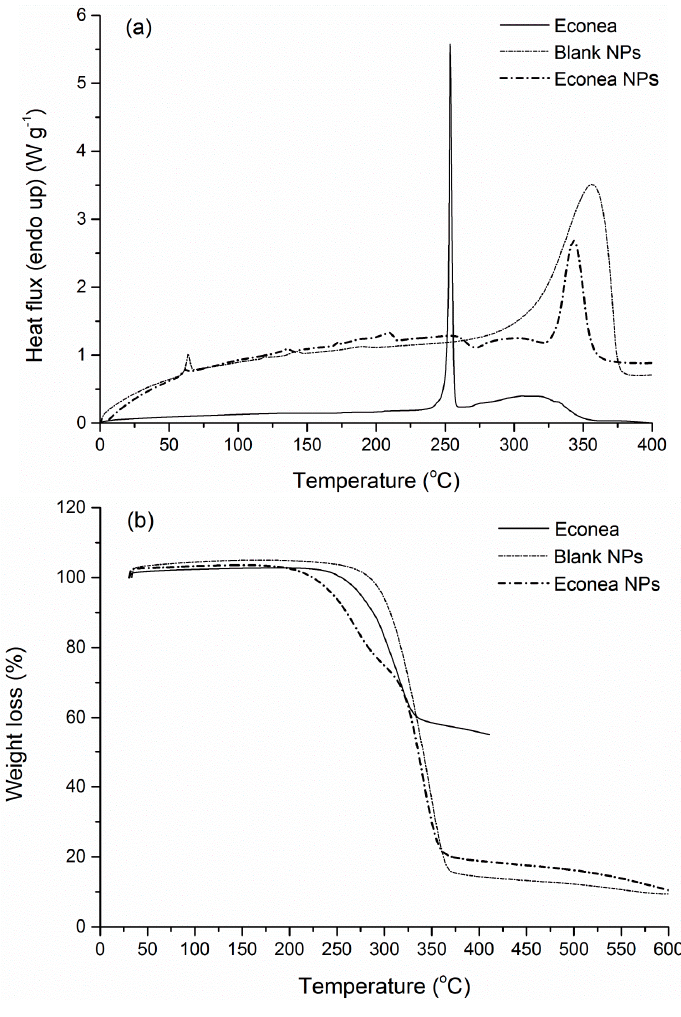
Figure 9. ( a ) DSC and ( b ) TGA curve of Econea NPs and comparison curves. Table 4. Thermal properties of PLA, biocides and prepared nanoparticles